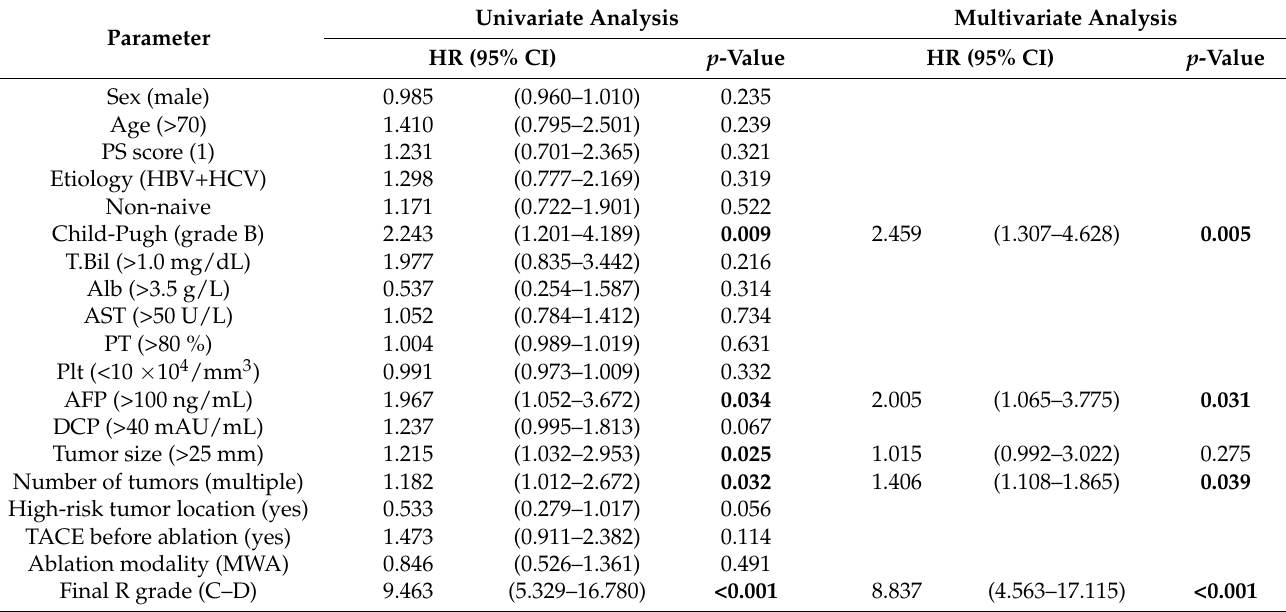
Table 4. Univariate and multivariate analysis for recurrence-free survival in the propensity score-matched cohort.